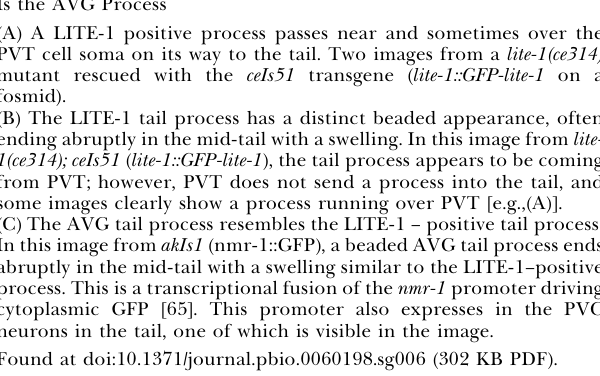
Figure S2. The Wild-Type Response to Light Is Restricted to Short Wavelengths power. Dashed lines indicate basal locomotion rates in low power white light and in the highest power of UV light that we could project onto the culture plate. Although the UV light is only one-seventh of the power of the other wavelengths, it produces a response similar to a much higher power of blue-violet light. Error bars are the standard errors of 10 animals. PLoS Biology |